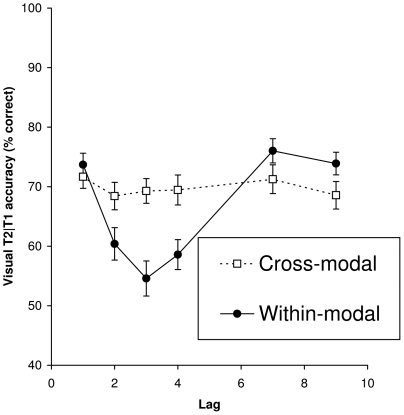
Visual T2 accuracy.Mean percentage correct report of a visual T2 given correct report of T1 as a function of lag when presented within (solid line) or between modalities (dotted line).